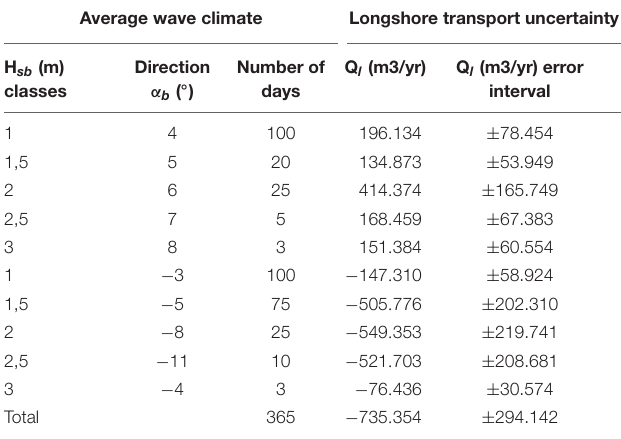
TABLE 4 | Condensed average wave climate for the Spanish Mediterranean coast, indicating the number of days (ND) and peak direction of wave incidence at the breaker line ( θ b